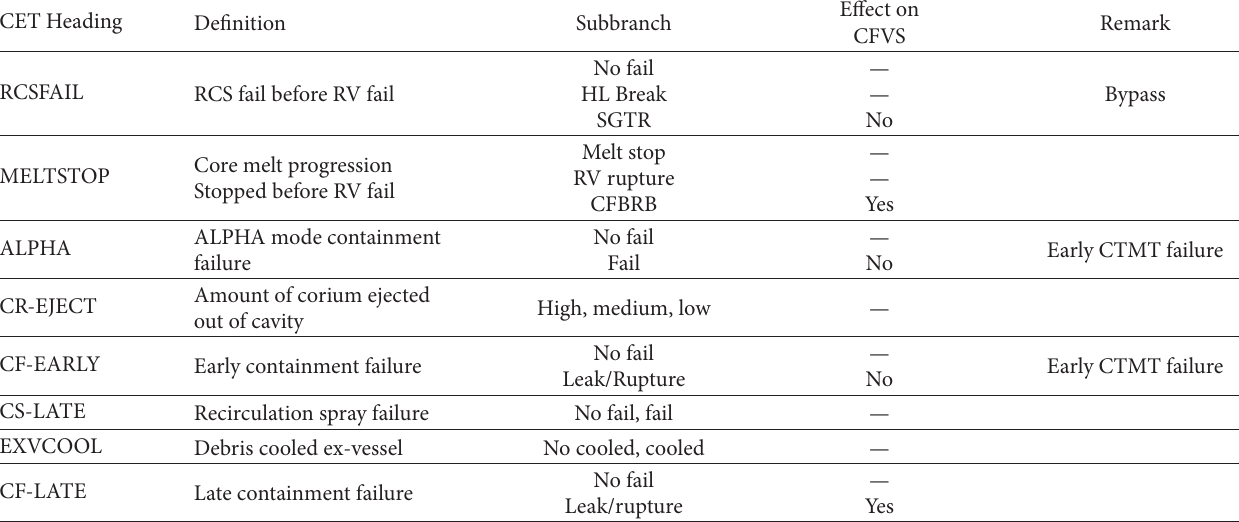
Table 5: Containment event tree of